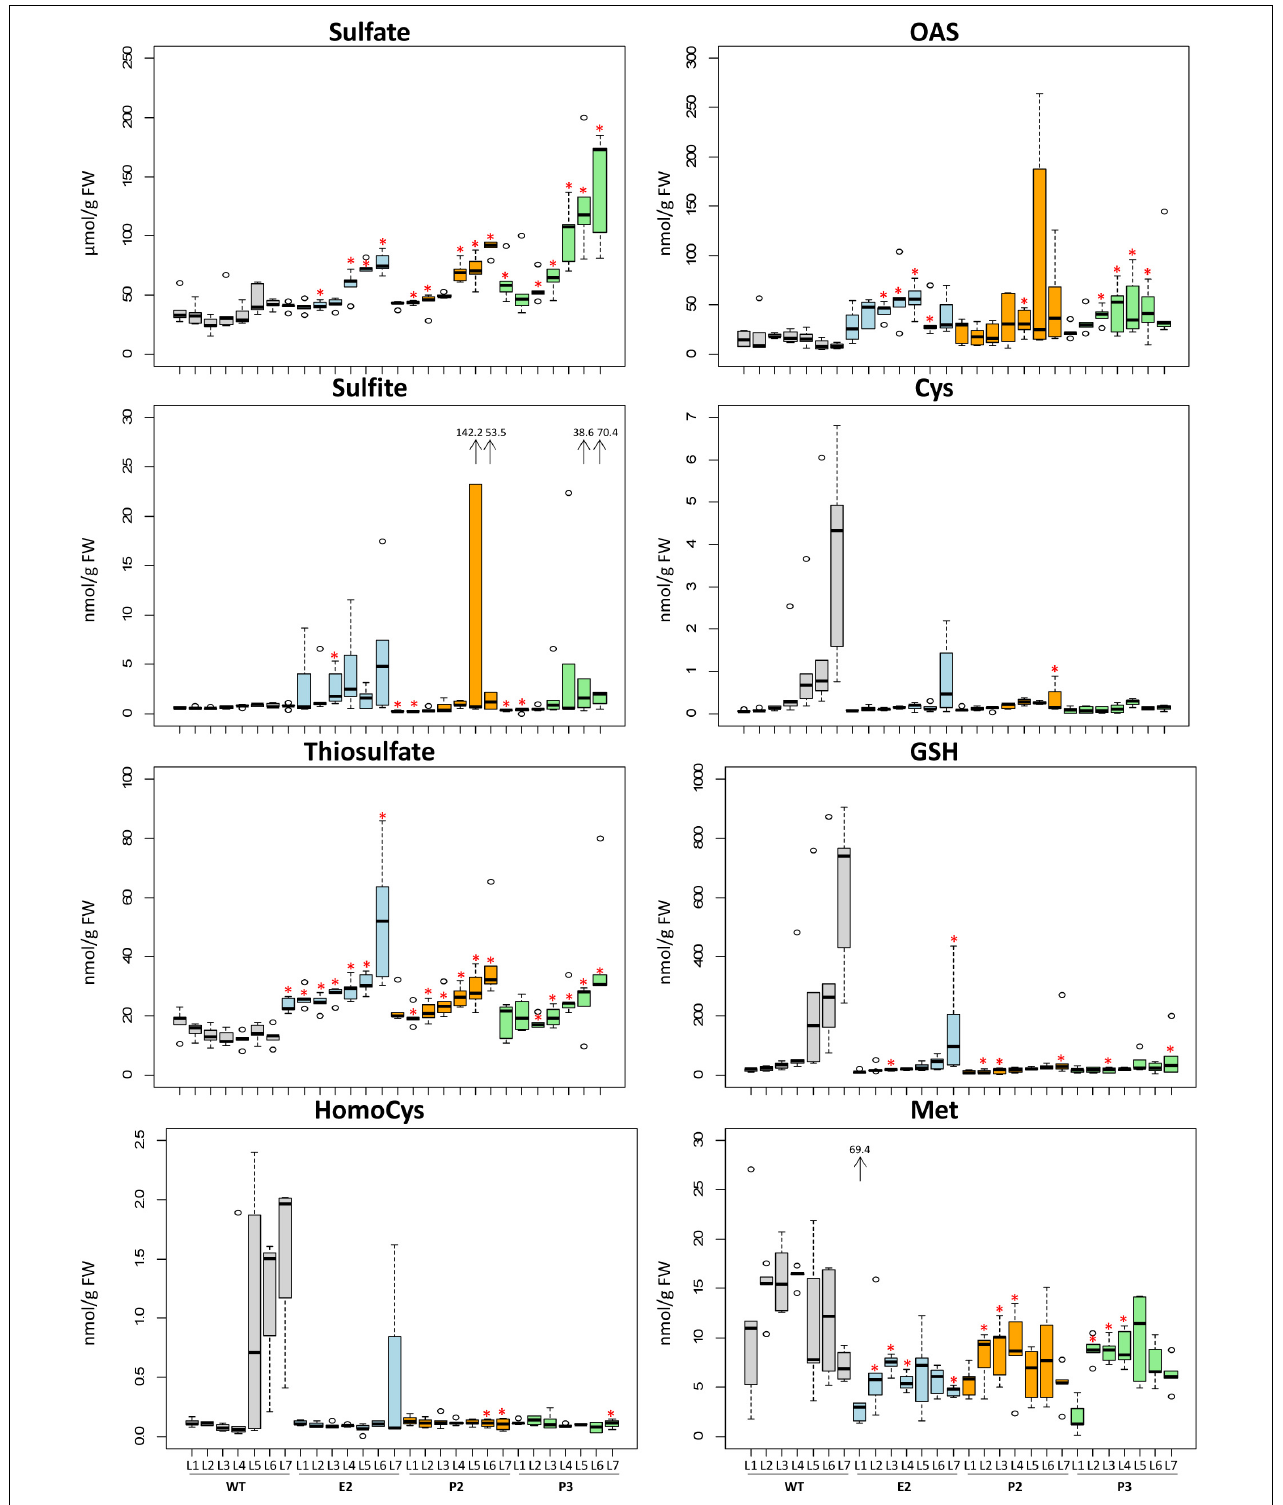
FIGURE 3 | Changes of contents of metabolites related to sulfur metabolism. Boxplots show metabolite changes in sulfur metabolism. Details of boxplot interpretation are given in Figure 2 . Extreme outliers were shown with arrows and the values. Differences between the wild-type and transgenic lines were analyzed using Student’s t -test and statistical significance was indicated ( ∗ P <